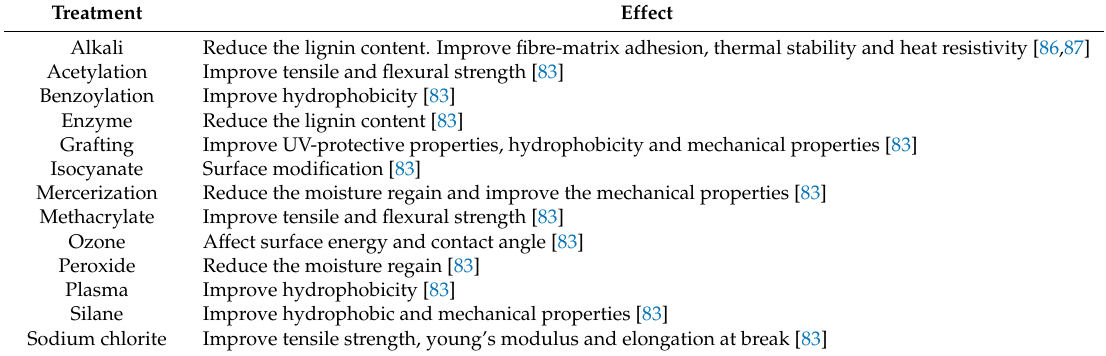
Table 6. The effect of chemical treatments on the functional properties of natural fibre. Adapted from: [83,86,87].